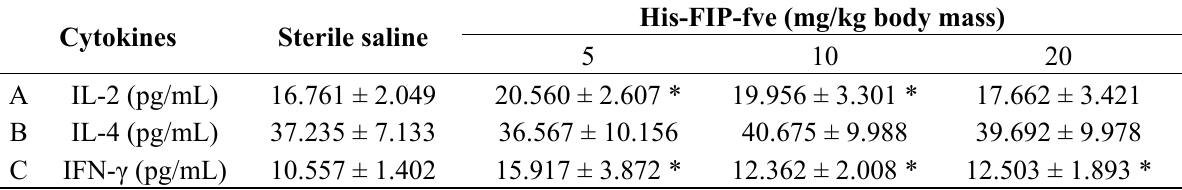
Table 2. Effects of His-FIP-fve on the serum cytokines IL-2, IL-4, and IFN- γ in mice in vivo ( n = 8). Mice were injected (i.p.) with sterile saline as negative control and His-FIP-fve by 5, 10, and 20 mg/kg body mass, and continuously treated for 3 d at 0.5 mL once a day. After 1 h during the last injection, blood was collected to obtain sera. IL-2, IL-4, and IFN- γ were detected by ELISA as described in the Materials and methods section. The levels of IL-2 (line A), IL-4 (line B), and IFN- γ (line C) were shown. p < 0.01 was considered an extremely significant difference and p < 0.05 was considered significant under the t-test. ** p < 0.01, * p < 0.05 (compared with the